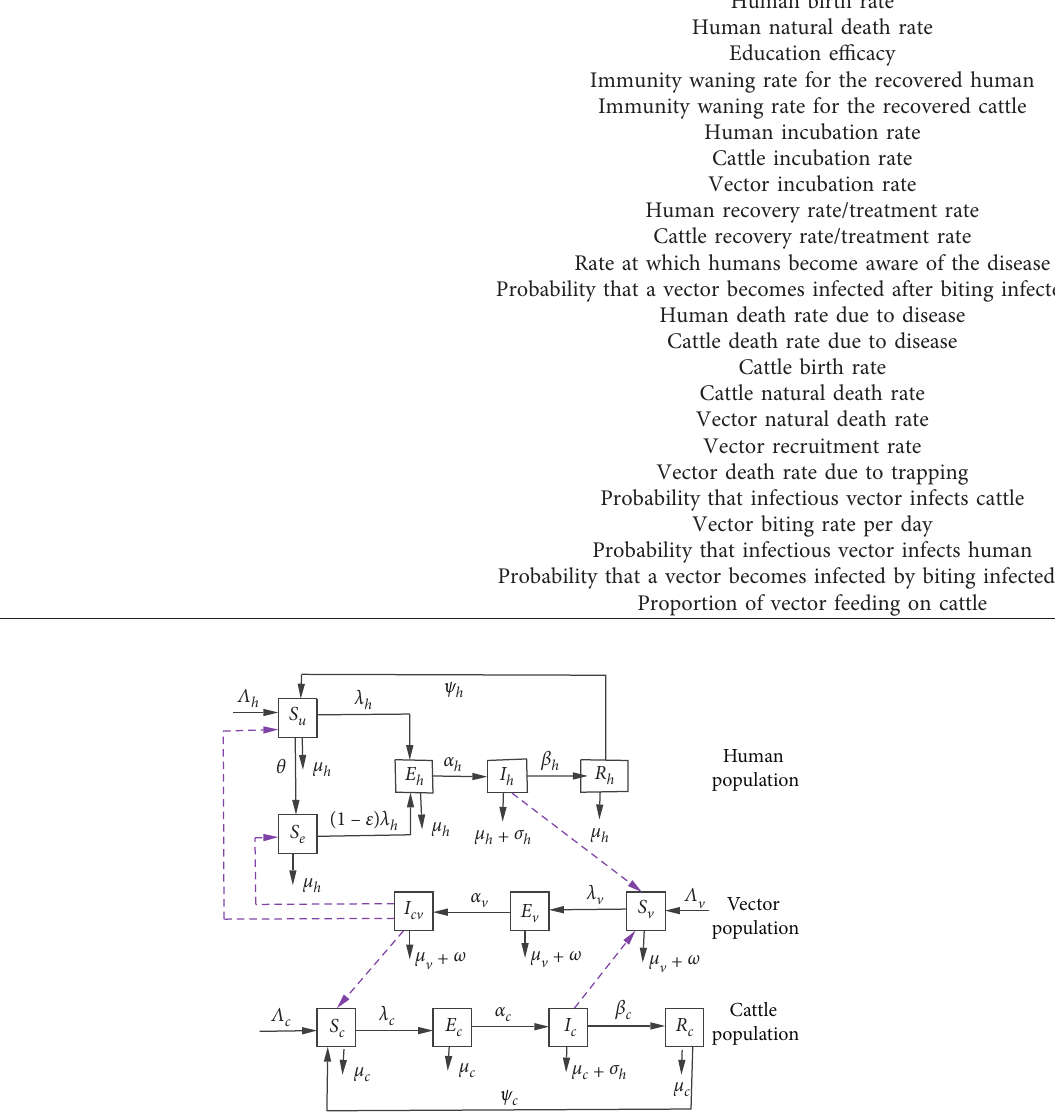
Figure 1: Flow diagram for the dynamics of African